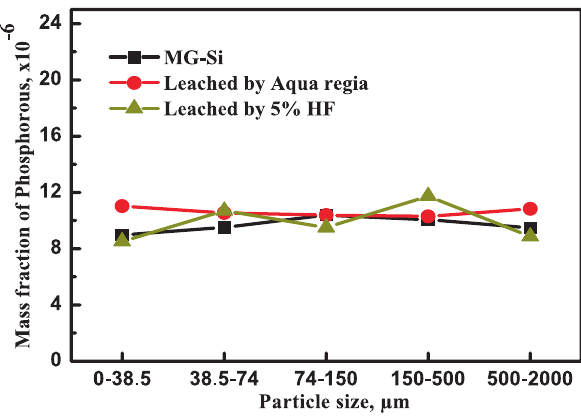
Fig. 5: Comparison of mass fraction of phosphorus in Si after different acid